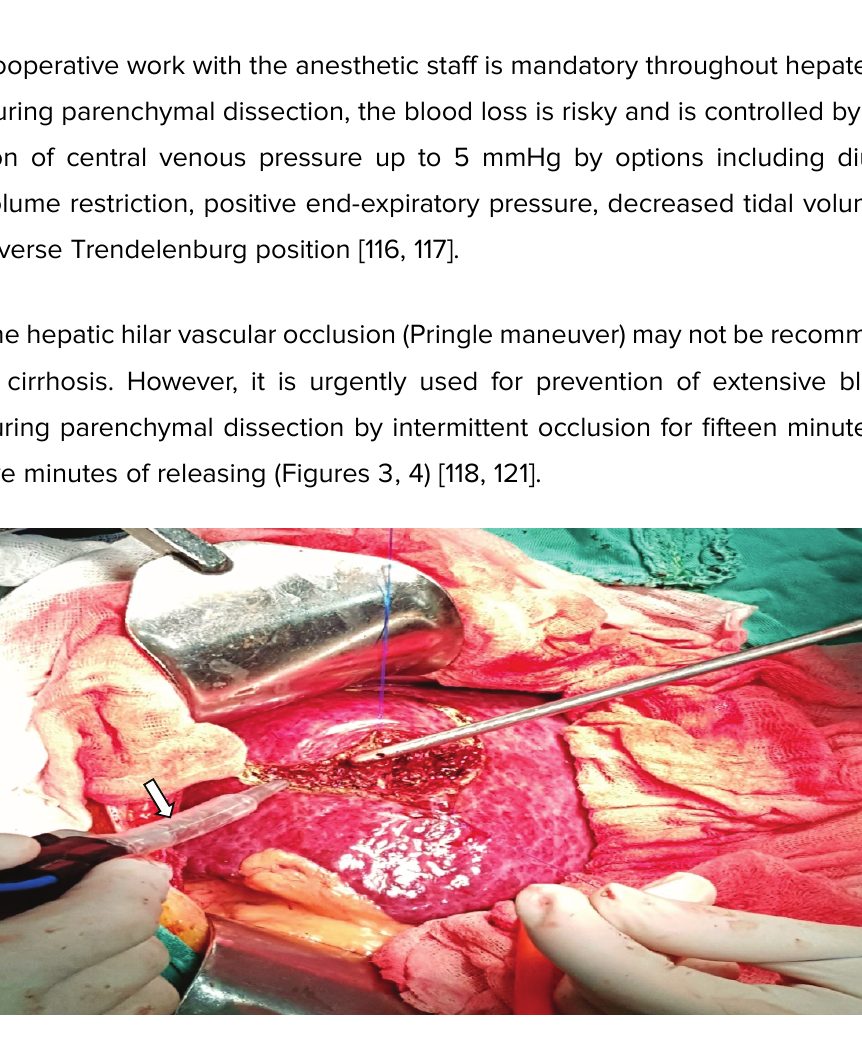
Figure 3: Intraoperative CUSA circumferential HCC resection in cirrhotic liver using intermittent hilar vascular occlusion.